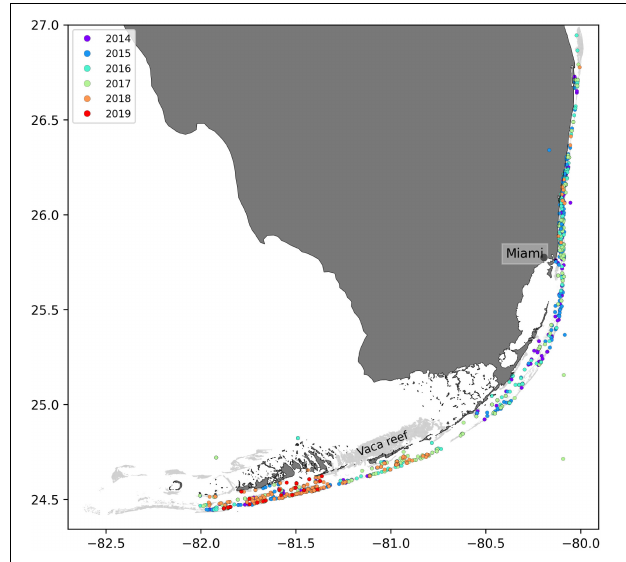
FIGURE 2 | Locations of the disease observations between 2014 and 2019 recorded in the data sets used in this